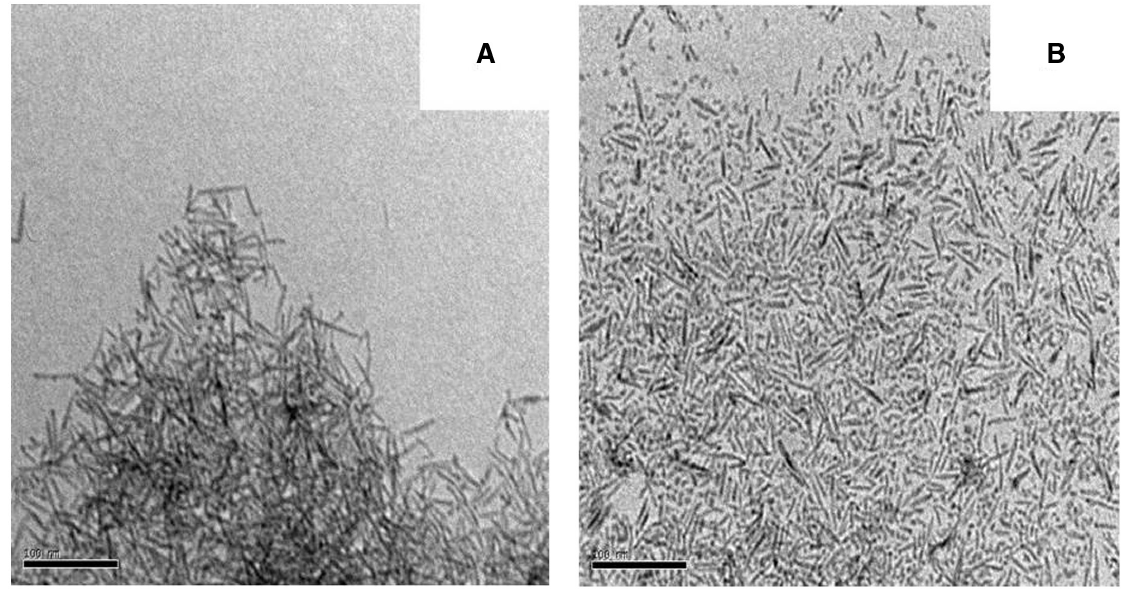
and OA- Figure 3 FTIR spectra of OA-OM-capped-TiO 2 TiO (A2) nanoparticles, pure OA, OM, and 2